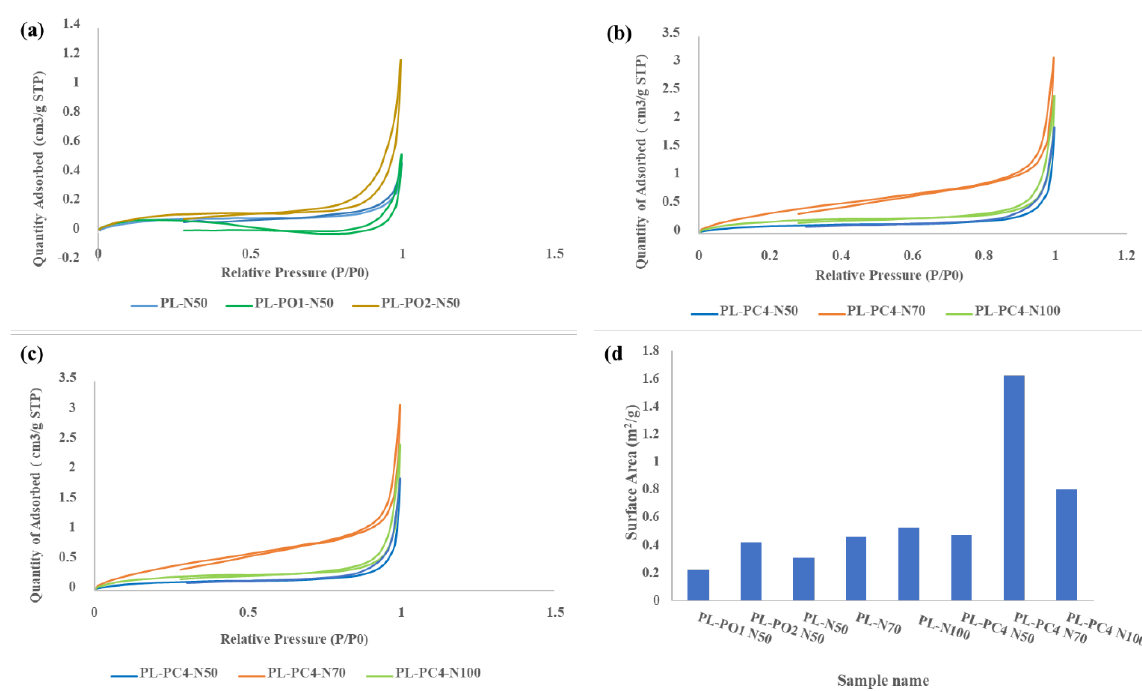
Figure 5. The hysteresis loops for porous PLA and porous PCL/PLA films ( a ) porous PLA with different percentages of PEO ( b ) porous PLA films with different percentages of NaCl ( c ) porous PCL/PLA films with different percentages of NaCl ( d ) the Brunauer–Emmett–Teller (BET) surface area of porous PLA and porous PCL/PLA films.